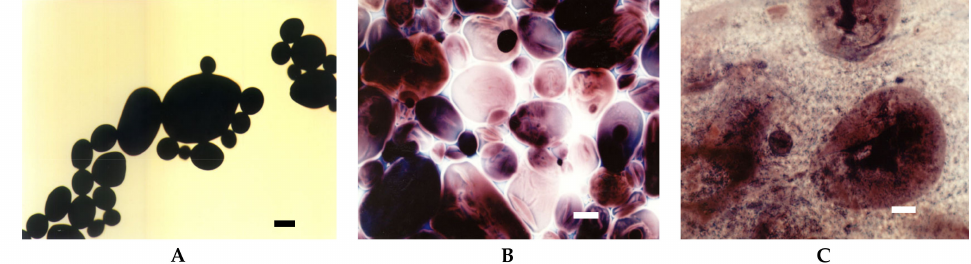
Figure 1. LM micrographs (20 × ) of native potato starch dispersions incubated at di ff erent temperatures